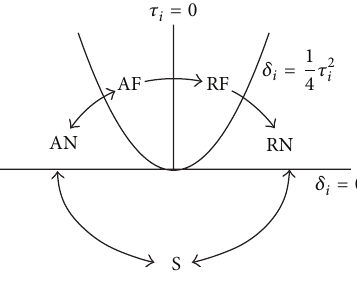
Figure 3: The trace-determinant